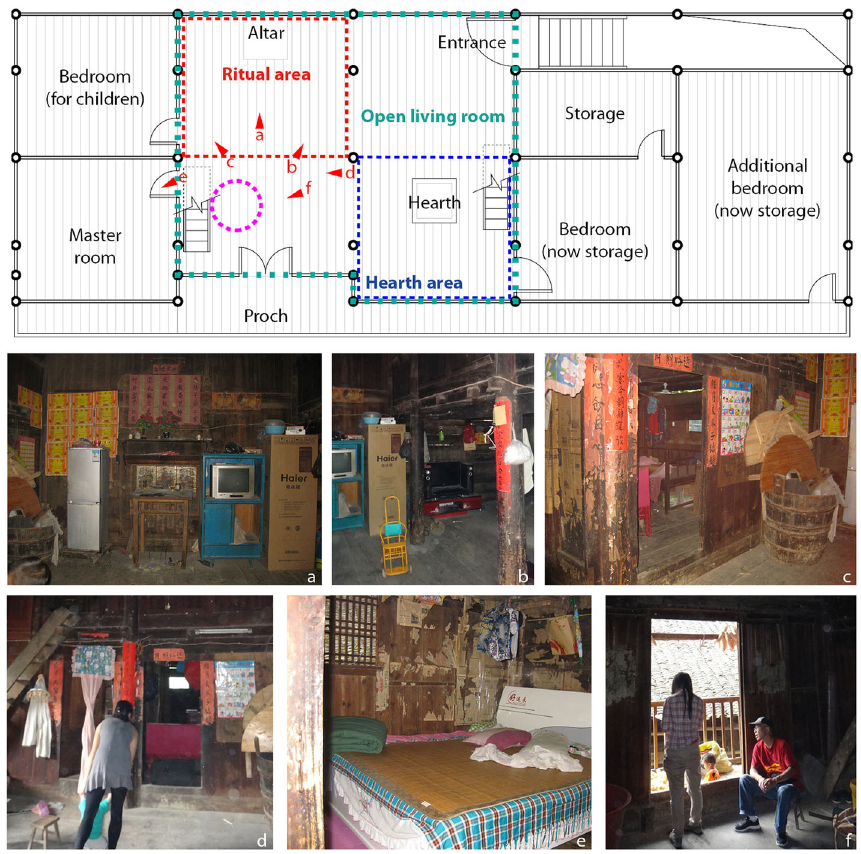
Fig. 11 Floor plan and photos of S4 show that its layout was similar to type A: it had a front (entrance, photo b), middle (ritual area, photo a), and rear (P area, photo d and master bedroom, photo e). It also had a T-shaped porch (photo f), which is similar to type B to emphasise the orientation of the altar and ritual area (photo a) (Source: the